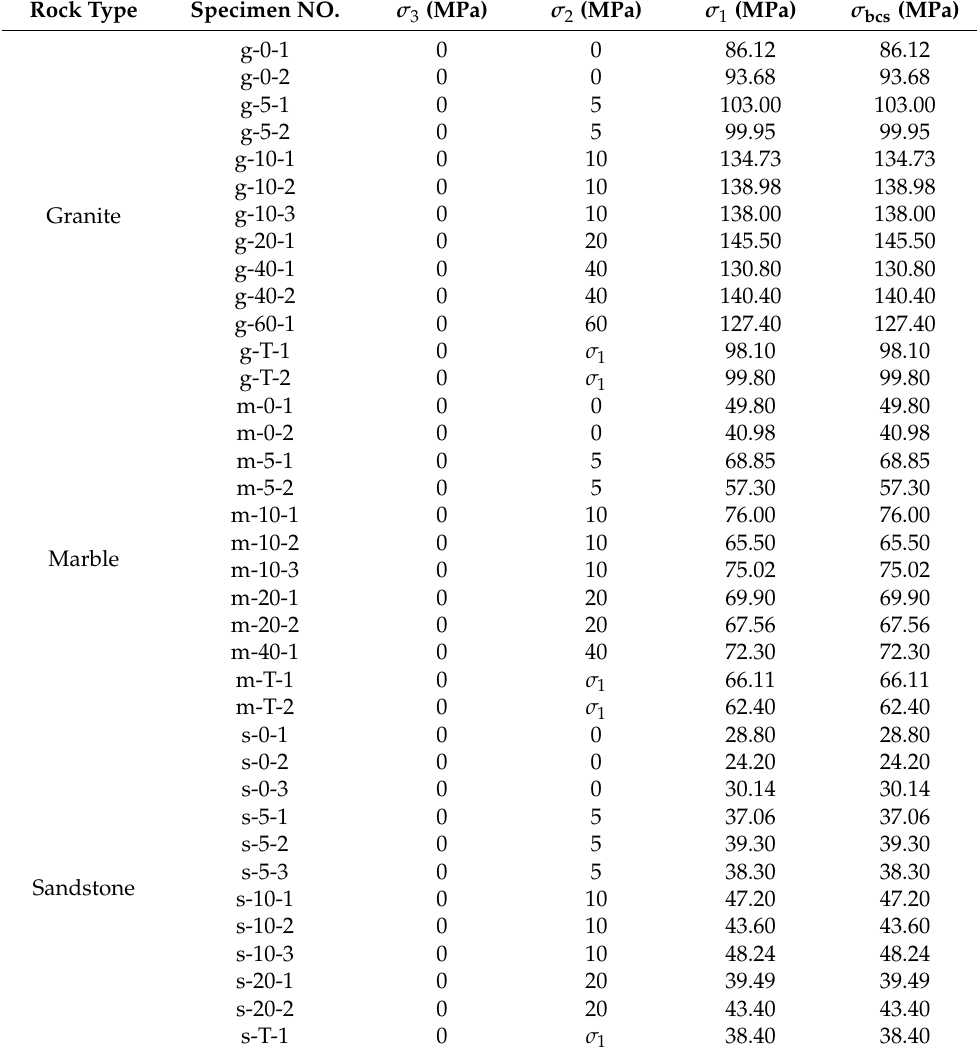
Table 3. Biaxial compressive strengths of granite, marble, and